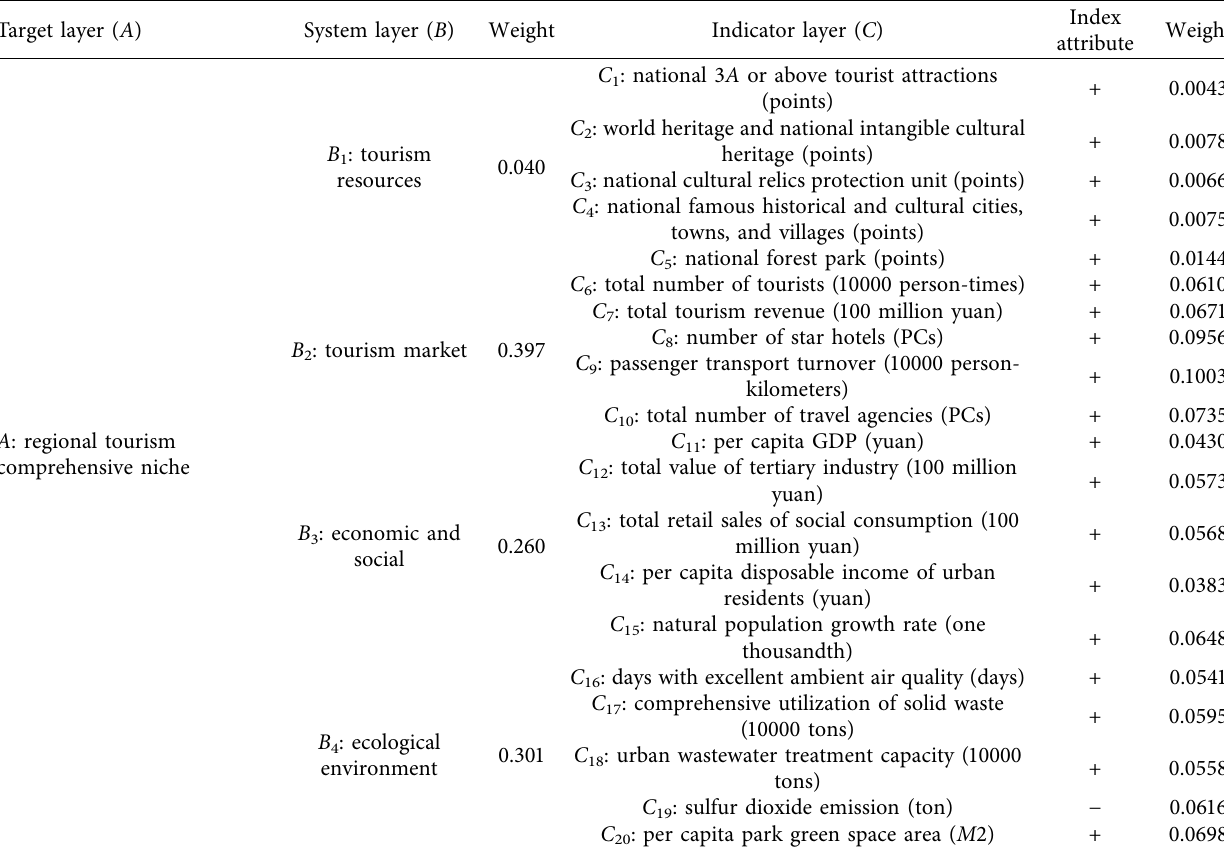
Table 1: Composite niche system of urban tourism and index